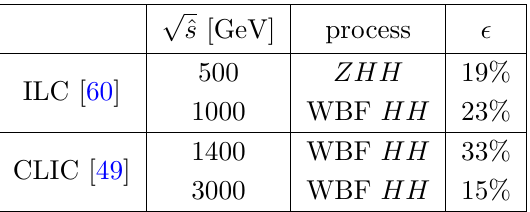
Table 5 . Expected precision (cid:15) for the measurements of double Higgs production processes. For the ILC the values of (cid:15) have been obtained rescaling the values in [60] to the luminosity of table 4. In the case of CLIC, we have derived the values of (cid:15) via the relations in section 9 of ref.